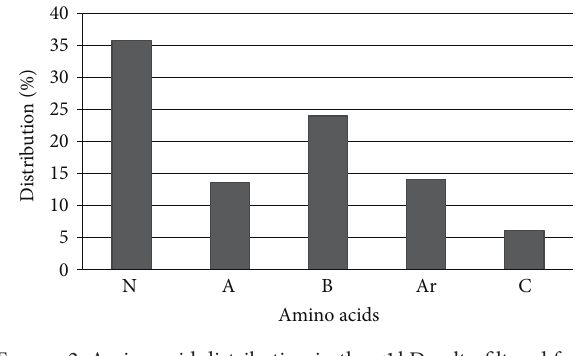
Figure 2: Amino acid distribution in the < 1kDa ultrafiltered frac- tion of a S. hispanica protein hydrolysate. N: neutral amino acids (including Gly, Ala, Ser, Thr, Val, Leu, and Ile). A: acid amino acids (including Asp and Glu). B: basic amino acids (including Lys, His, and Arg). Ar: aromatic amino acids (including Phe, Tyr, and Trp). C: cyclic amino acids (including